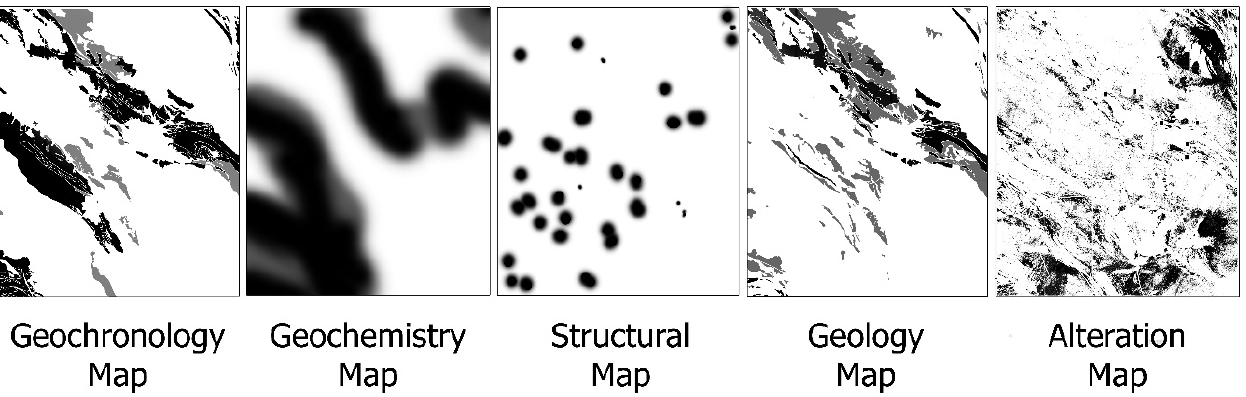
Figure 12. The fuzzified exploratory maps for the Sahlabad mining area.